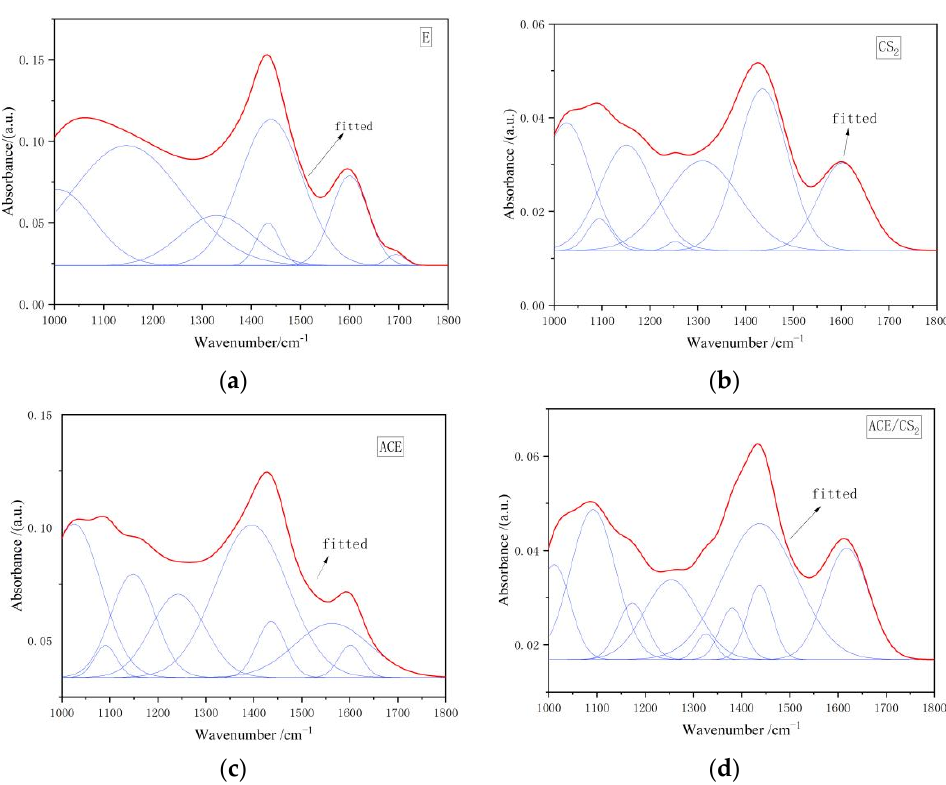
Figure 8. Infrared spectra of the original and extractive residues in the 1000–1800 cm − 1 region. (( a ) is an original tar residue fit, ( b ) is a fit to carbon disulphide, ( c ) is a fit to acetone and ( d ) is a fit to a mixed solvent. The red line is the fit line and the blue line is the sub peak). Table 8. Infrared spectra of four samples 1000–1800 cm − 1 split peak fitting ratio of each absorption peak area.